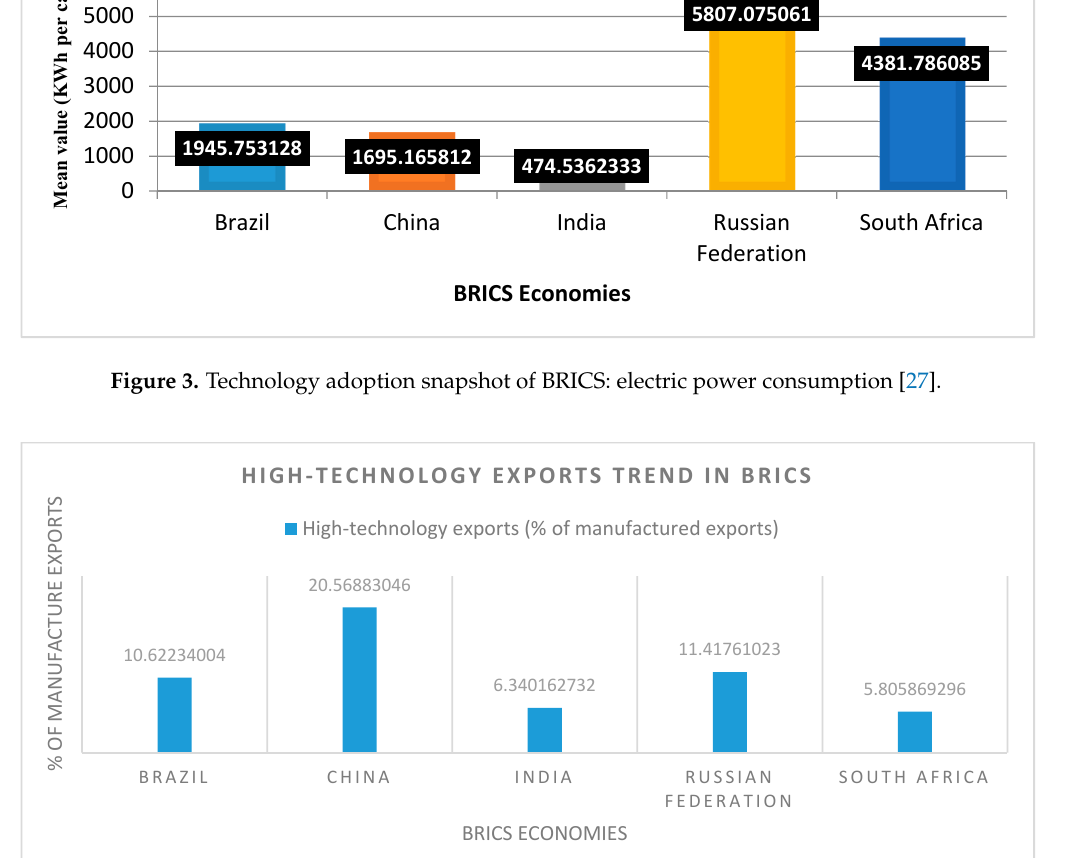
Figure 4. Technology adoption snapshot of BRICS: high-technology exports [27].